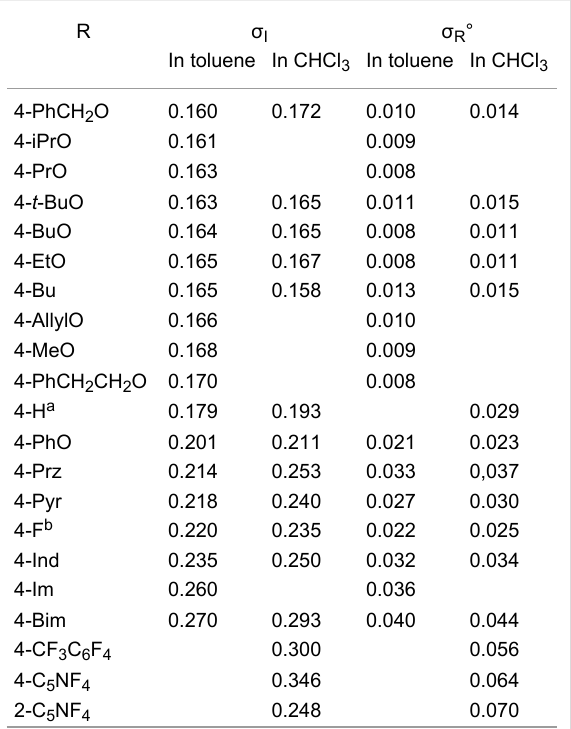
Table 6: The substituent electron parameters (SEP) of 4-RC 6 F 4